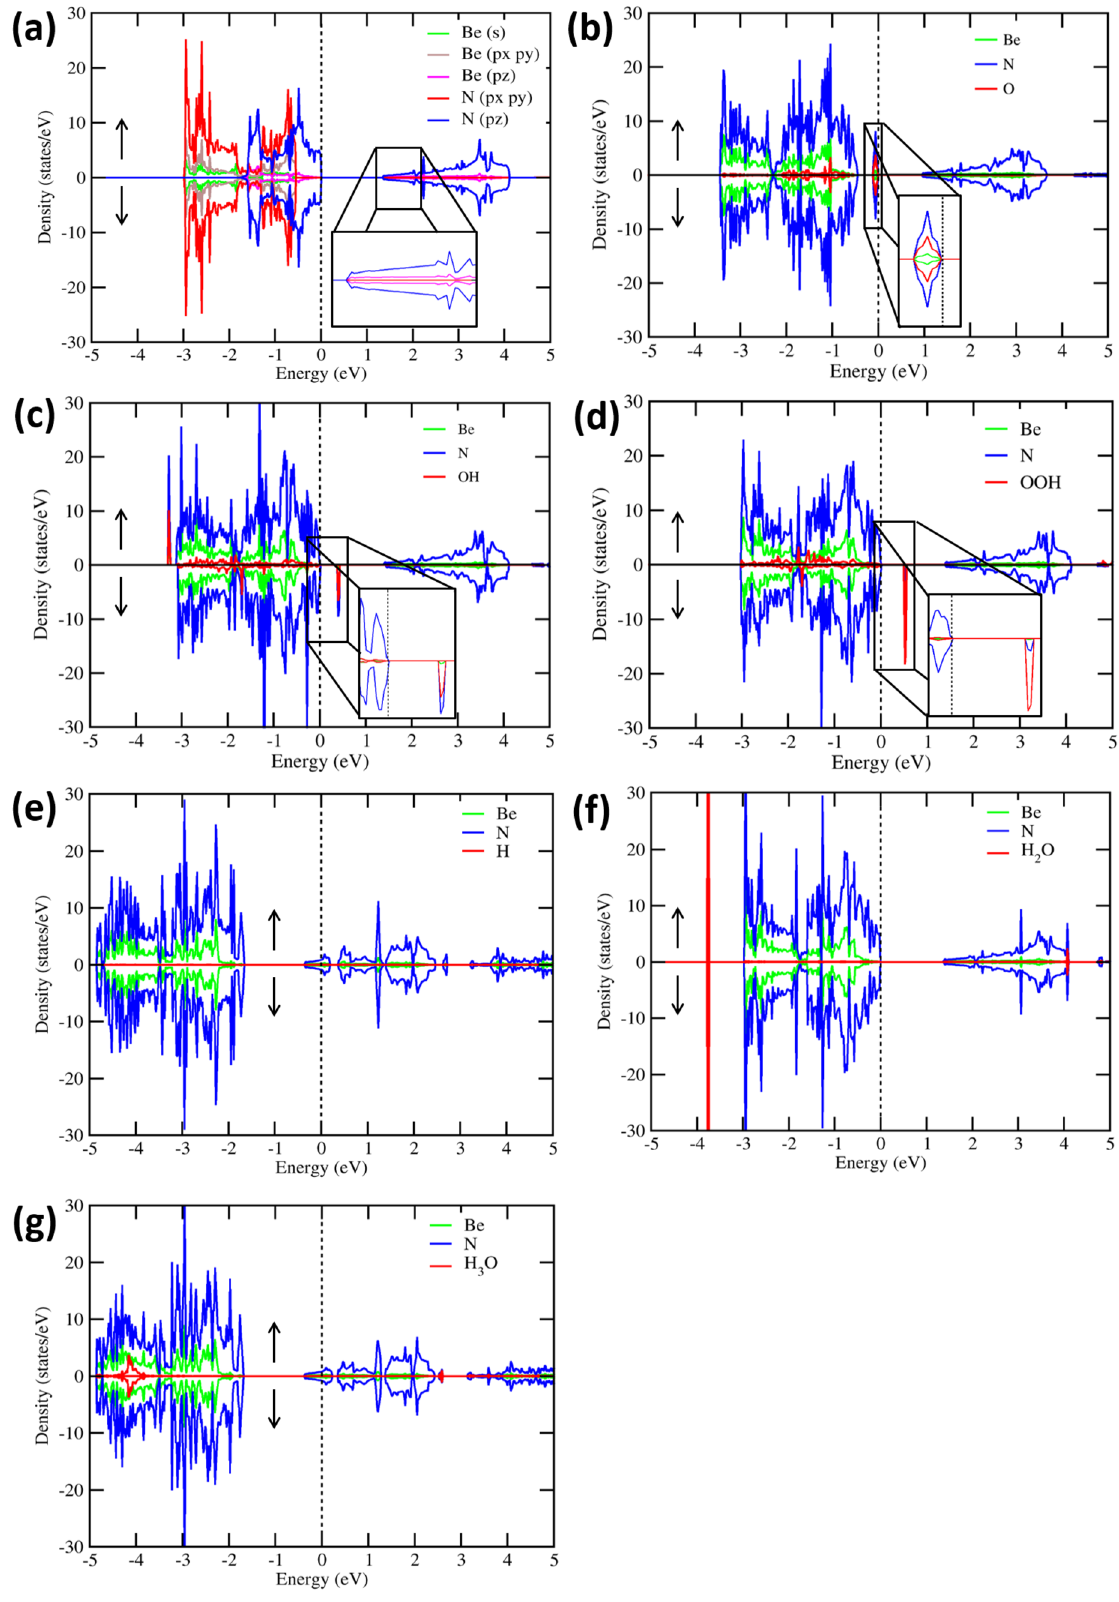
Figure 2. Calculated partial density of states for ( a ) a BeN 2 monolayer, and for the ( b ) O, ( c ) OH, ( d ) OOH, ( e ) H, ( f ) H 2 O, and (g) H 3 O adsorbates onto the BeN 2 monolayer. Arrows indicate the up ( ↑ ) and down ( ↓ ) spin channels. A magnified view of the states are shown in the